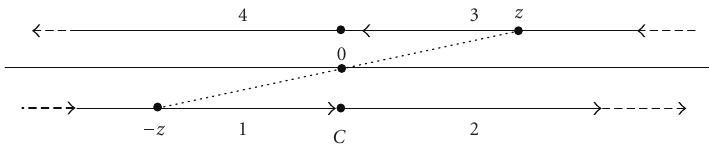
Figure 4.1. Segments for the computation of the integrals in (4.8) and